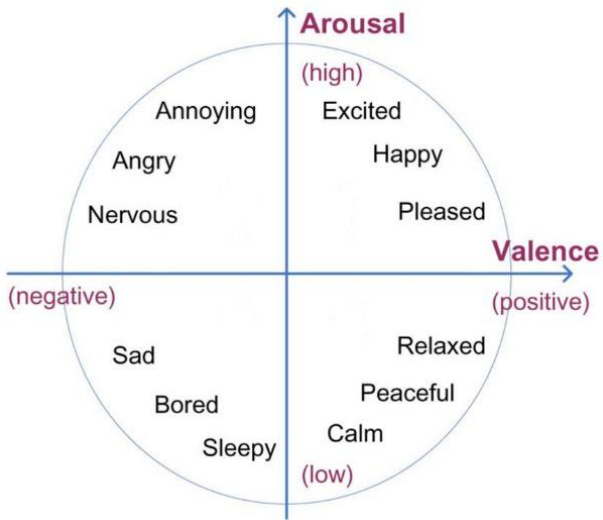
Figure 3. Thayer’s arousal -valence emotional plane.